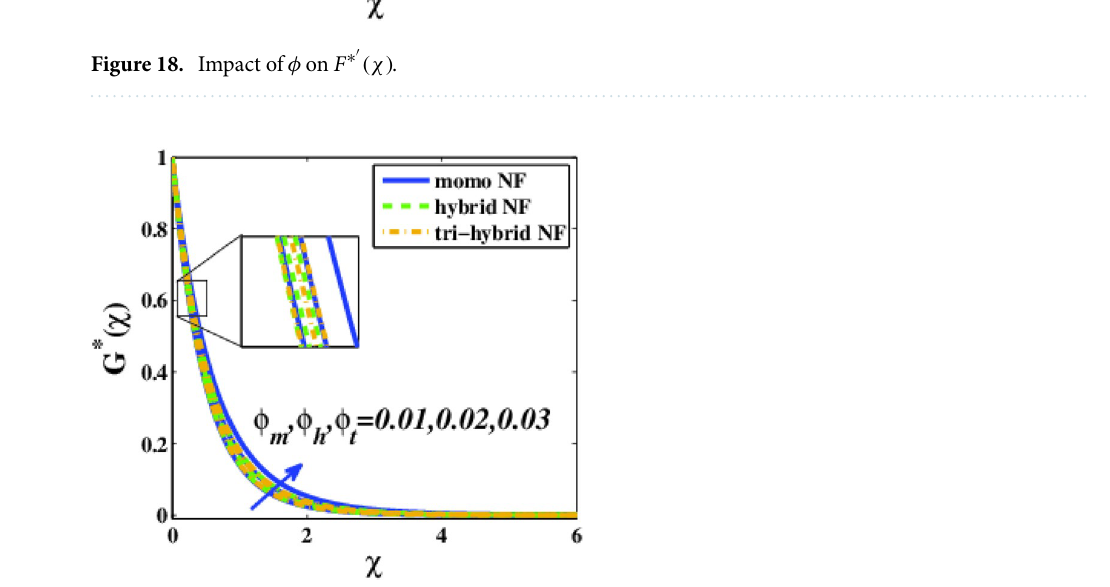
Figure 19. Encouragement of φ on G ∗ (χ)